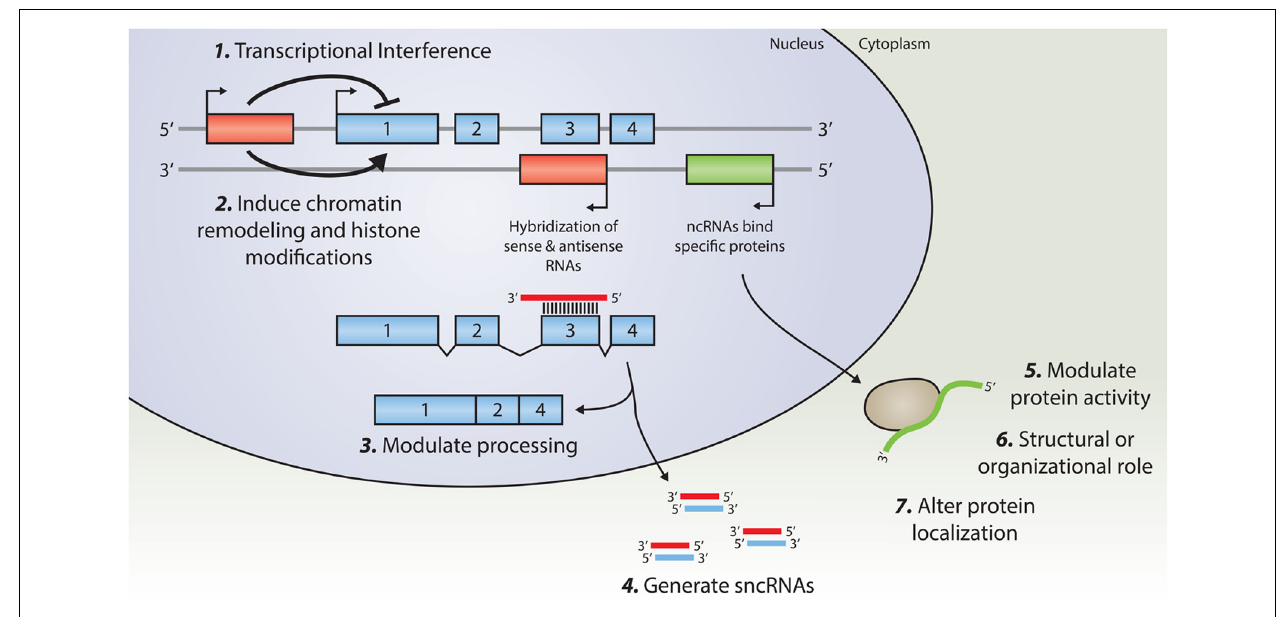
modulate further processing (3), or provide a substrate for Dicer, or other nucleases, in order to generate various small non-coding RNAs (4). By binding to specific protein partners, a long noncoding transcript may modulate the activity of that particular protein (5), serve as a structural component that allows the formation of a larger RNA–protein complex (6), or alter the cellular localization of the protein